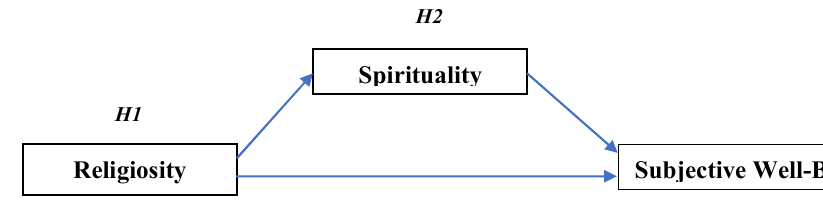
Figure 1. Hypothesized model.